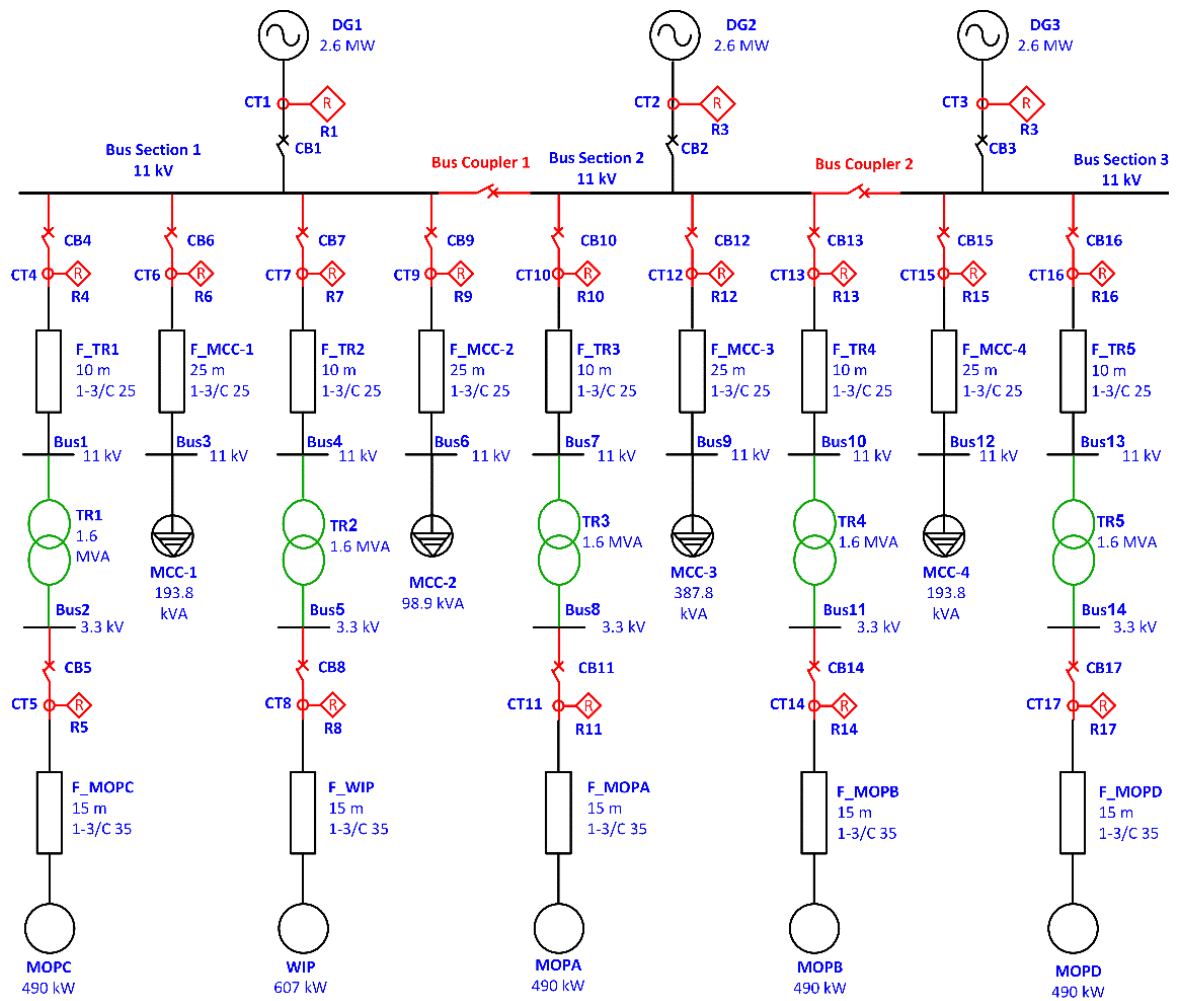
Figure 5. The SLD of Agiba test network.